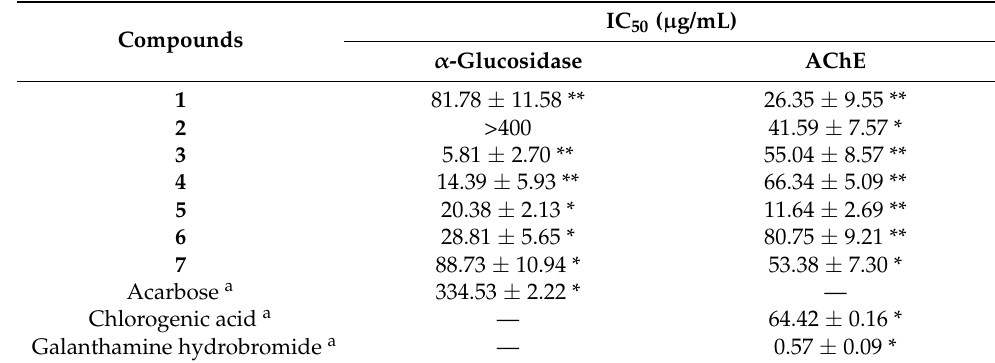
Main isolated components from Ampelopsis japonica of α -glucosidase and AChE inhibitory